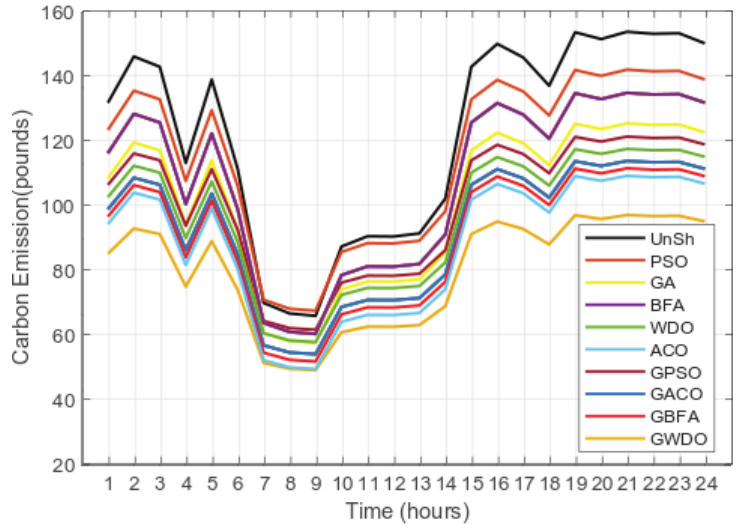
Figure 11. Case study 2: Carbon emission